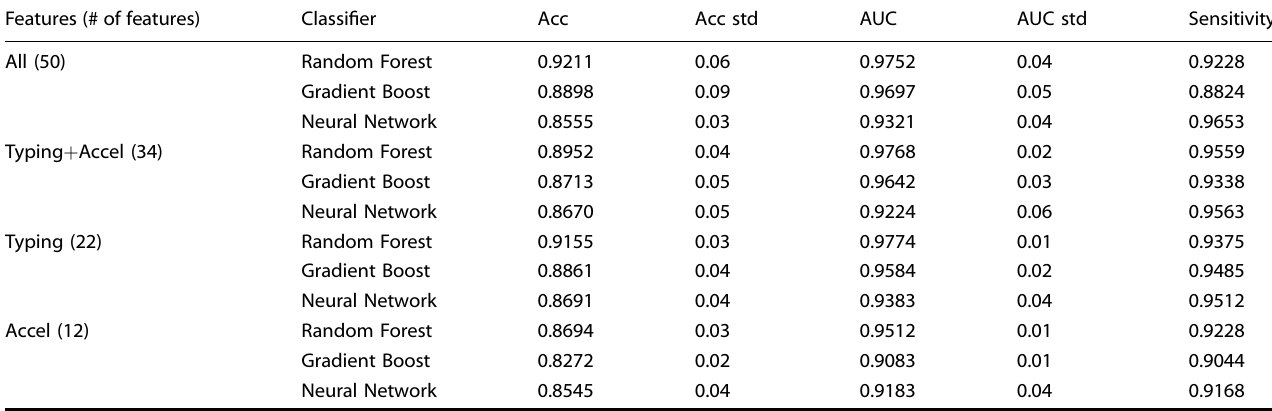
Table 3. Main results excluding missing data a